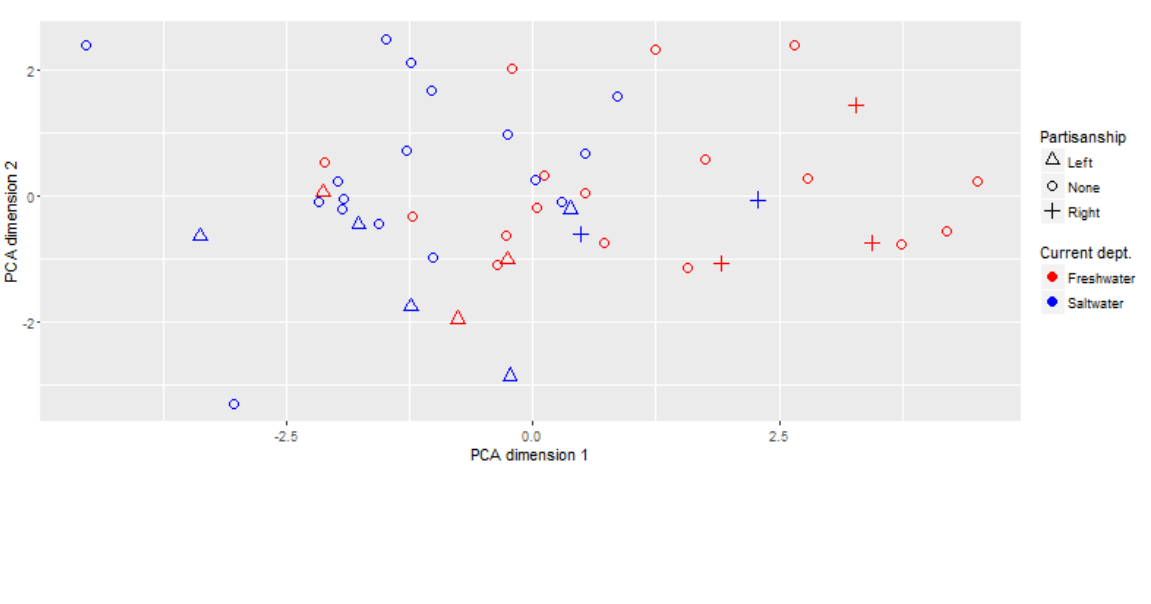
Figure 4: PCA results. Note: Each axis is scaled to the variance explained by the corresponding PCA dimension. Position on vertical axis is provided for visual clarity; this axis has no substantive interpretation (see